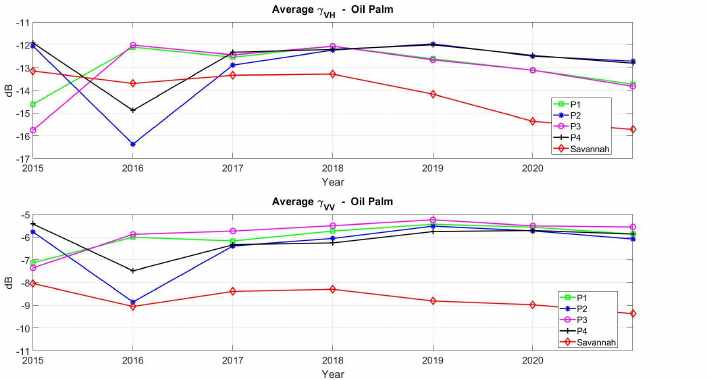
Figure 6. Time series of ( top ) VH and ( bottom ) VV channels for tropical forests polygons during the wet season. The time series of savannah are also provided.